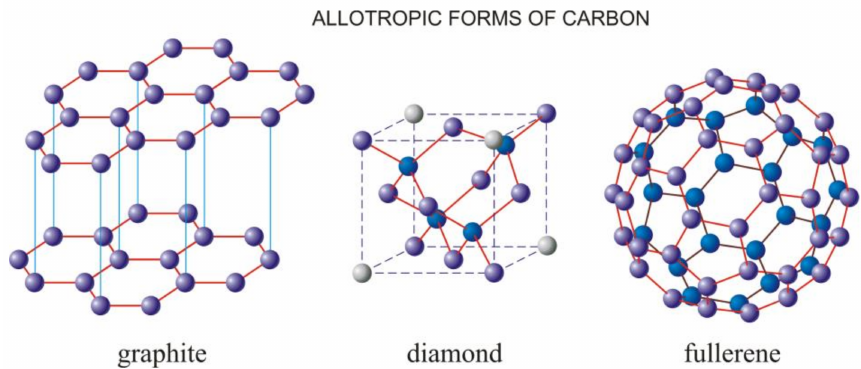
Figure 2. Various allotropes of carbon [11].